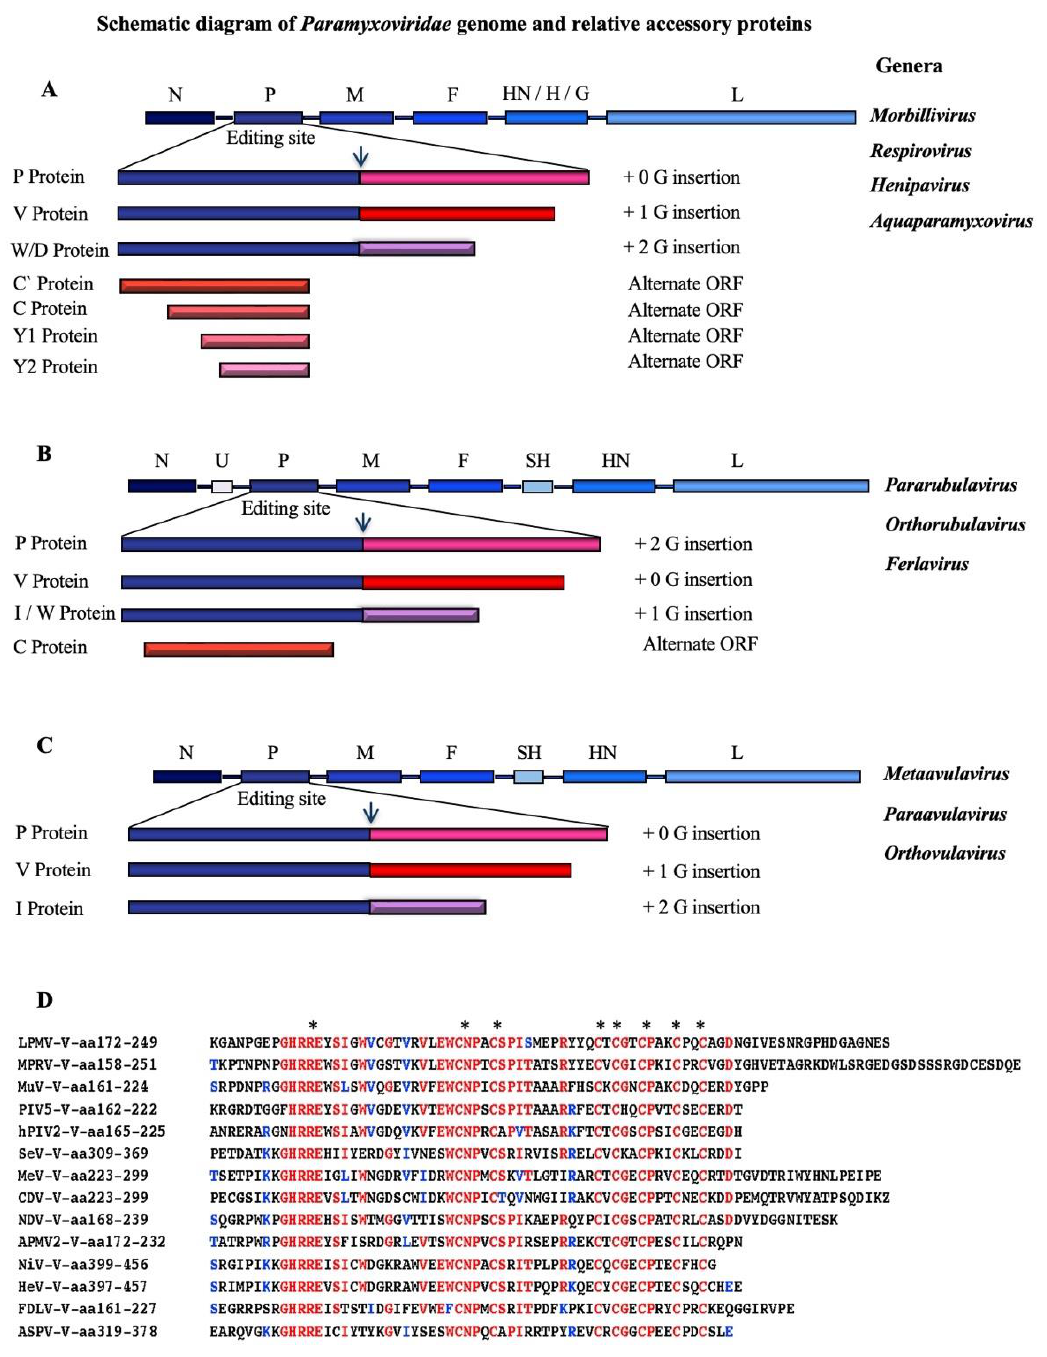
Figure 1. Paramyxoviridae genome organization, accessory proteins, and editing strategies. ( A ) Schematic diagram of the genome organization of the genera of Morbillivirus , Respirovirus , Heni- pavirus , and Aquaparamyxovirus . From the left to the right: the N gene, the P gene, the M gene, the F gene, the HN gene for Aquaparamyxovirus , Respirovirus or H gene for Morbillivirus , or G gene for Henipavirus and the L gene. The P proteins of Morbillivirus , Respirovirus , Henipavirus and Aquaparamyx- ovirus are generated without any G nucleotide insertions at the editing site. The V proteins are generated by the insertion of one G nucleotide at the editing site. The insertion of two G nucleotides generates the W protein and D protein only for HPIV3. The C proteins are generated using alternative ORFs, starting upstream at the P ORF. SeV P gene transcribes four C proteins: (C (cid:48) , C, Y1, and Y2), while HPIV3 P gene translates 3 C proteins (C (cid:48) , C and Y1). ( B ) Schematic diagram of the genome organization of the genera of Pararubulavirus , Orthorubulavirus , and Ferlavirus. From the right to the left: N gene, U gene (present only in Ferlavirus ), P gene, M gene, F gene, SH gene (present in Pa- rarubulavirus and Orthorubulavirus ), HN gene, and L gene. The P proteins of Pararubulavirus and Ferlavirus are produced by insertion of two G nucleotides at the editing site, while the V proteins